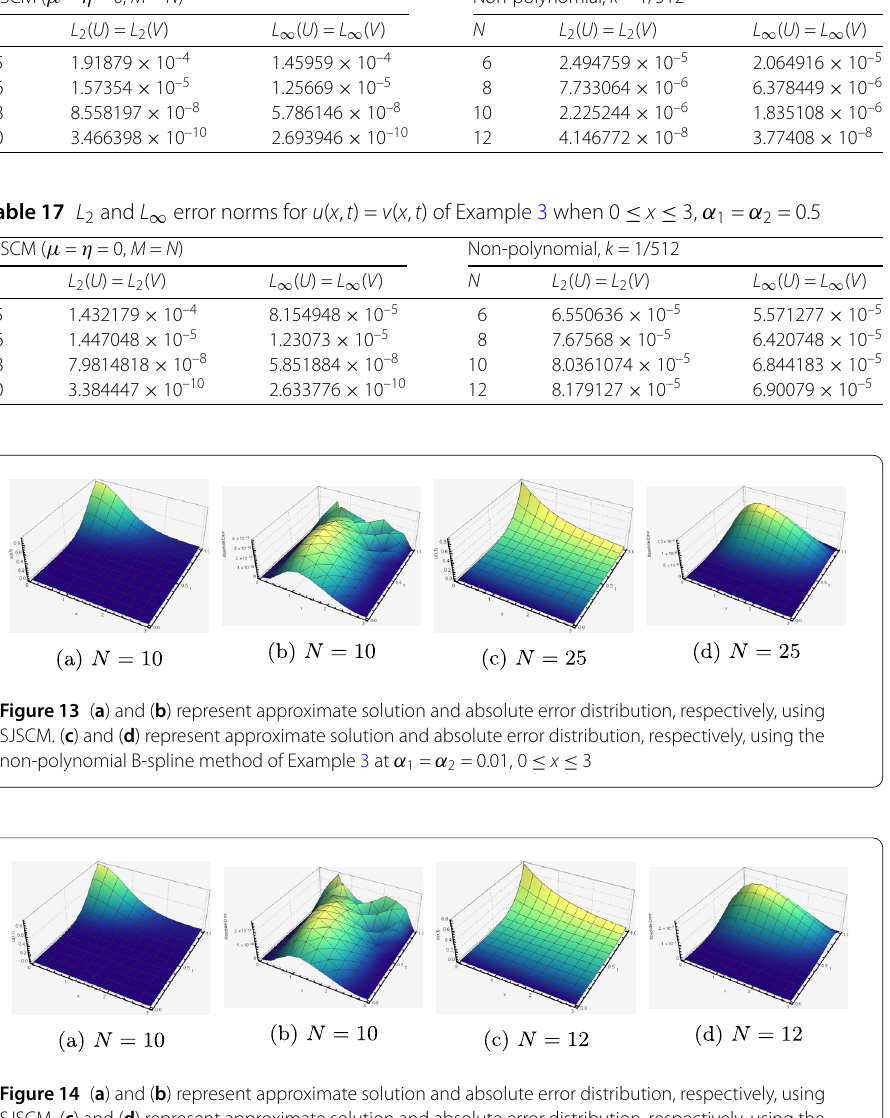
Table 16 L 2 and L ∞ error norms for u ( x , t ) = v ( x , t ) of Example 3 when 0 ≤ x ≤ 3, α 1 = α 2 = 0.1 SJSCM ( μ = η = 0, M = N )